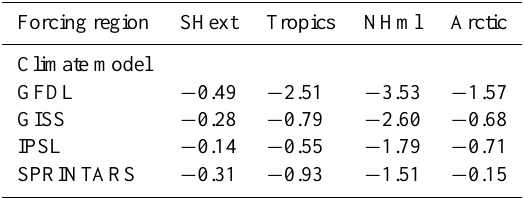
Table 2. Historical aerosol forcing (W m − 2 ) from the climate mod- els input to the temperature response estimates using the forc- ing/response portion of the